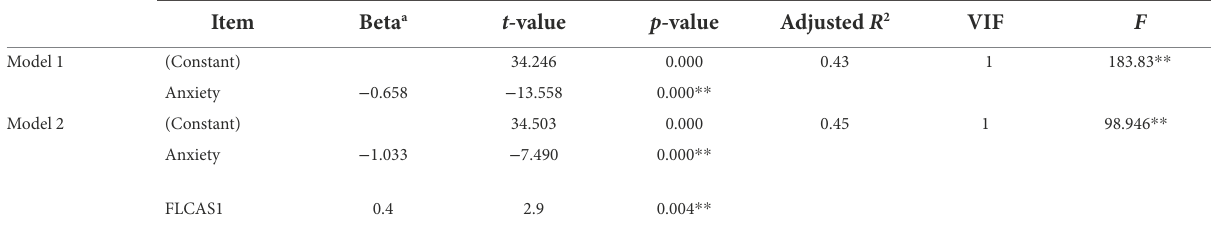
TABLE 4 A stepwise regression analysis between anxiety and